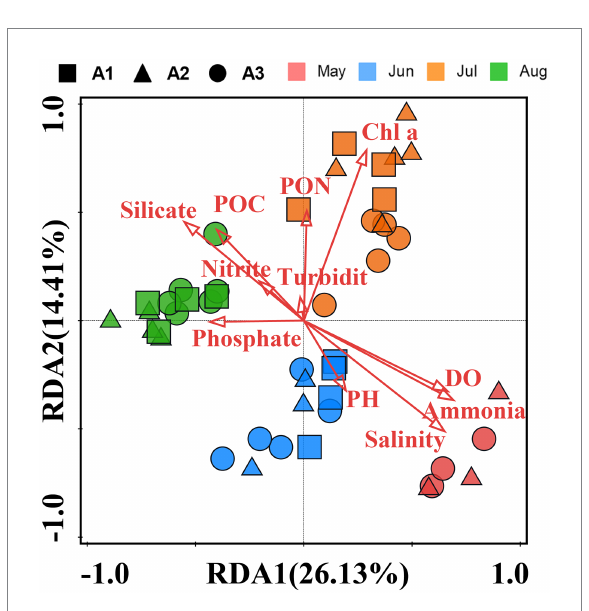
FIGURE 8 Redundancy analysis (RDA) was based on pathogenic bacteria composition and biotic/abiotic parameters as explanatory variables. The total variation explained in the abundance data is presented as two RDA axes (RDA1 and RDA2). Arrows represent environmental parameters. Different colored circles, boxes, and triangle symbols represent different